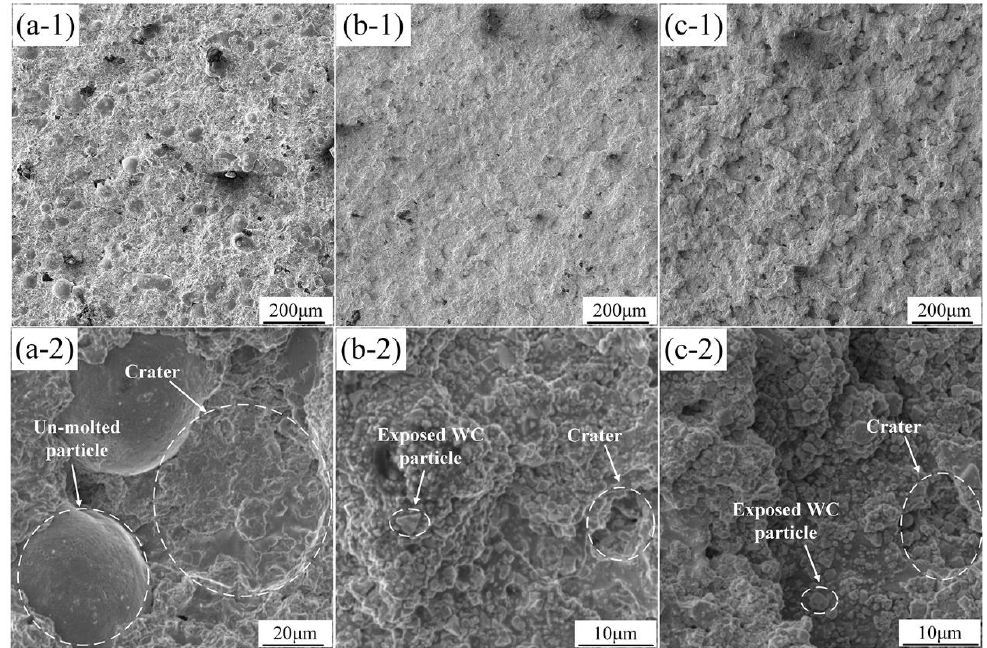
Figure 9. SEM images of eroded surfaces after cavitation test in deionized water: Cobalt-based alloy at low-magnification ( a – 1 ) and high-magnification ( a – 2 ); WC-12Co at low-magnification ( b – 1 ) and high-magnification ( b – 2 ); WC-17Co at low-magnification ( c – 1 ) and high-magnification ( c – 2 ).